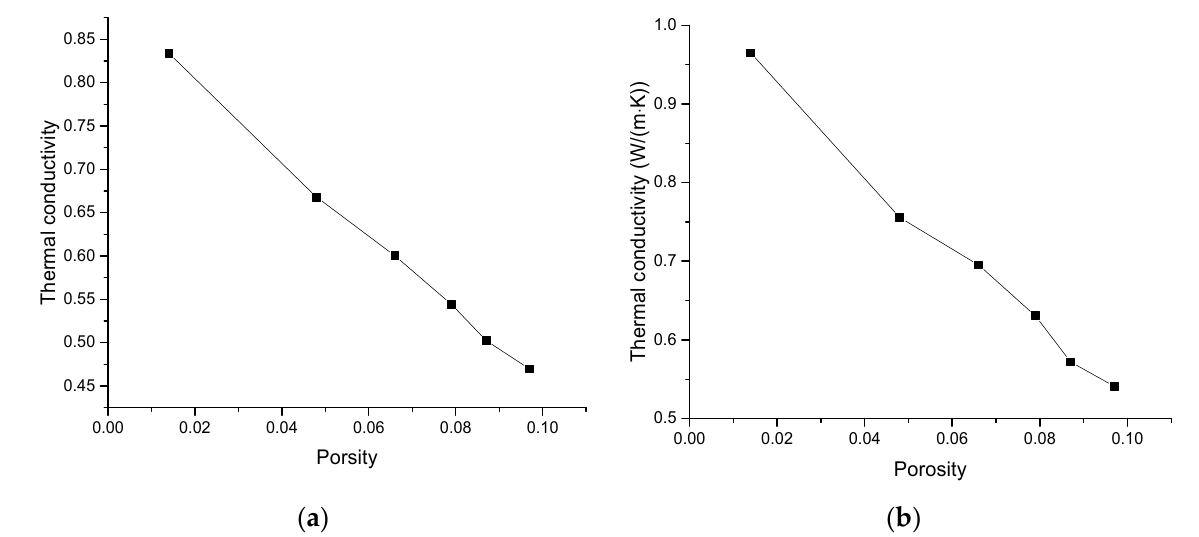
Figure 11. Relationship between thermal conductivity and porosity. ( a ) Perpendicular to bedding; ( b ) parallel to bedding.